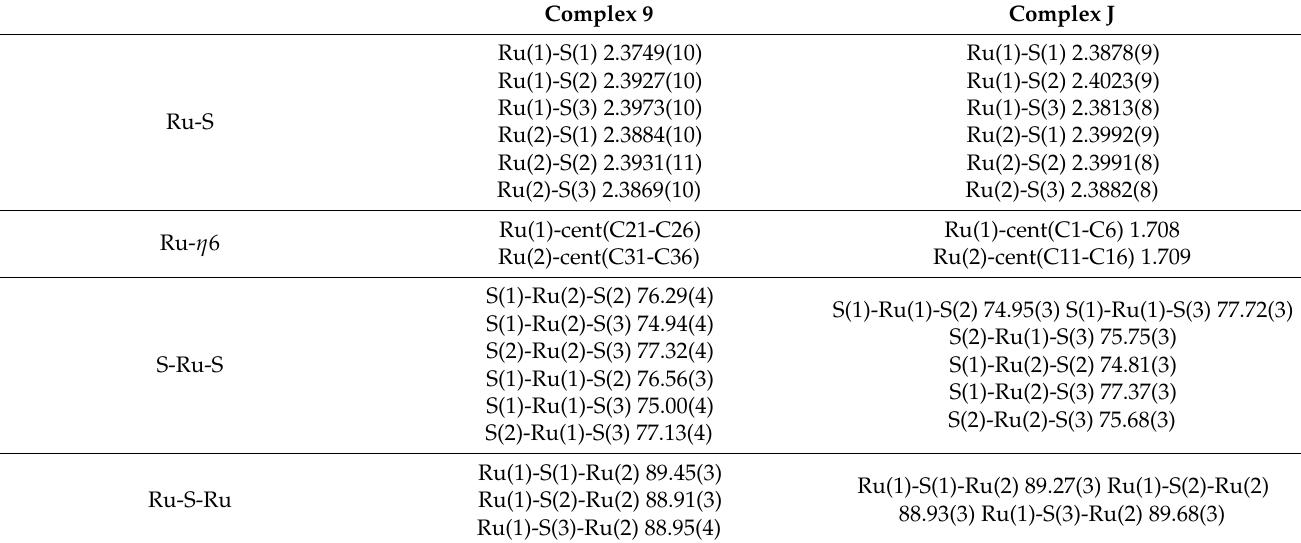
Table 2. Comparison of key bond lengths (Å) and angles ( ◦ ) of the diruthenium moiety in 9 and previously reported mixed complex J (Figure 4, data from ref.